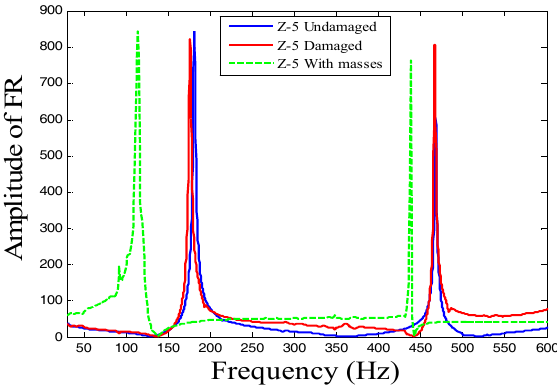
Figure 19. Sub-structure 5: The measured frequency response.